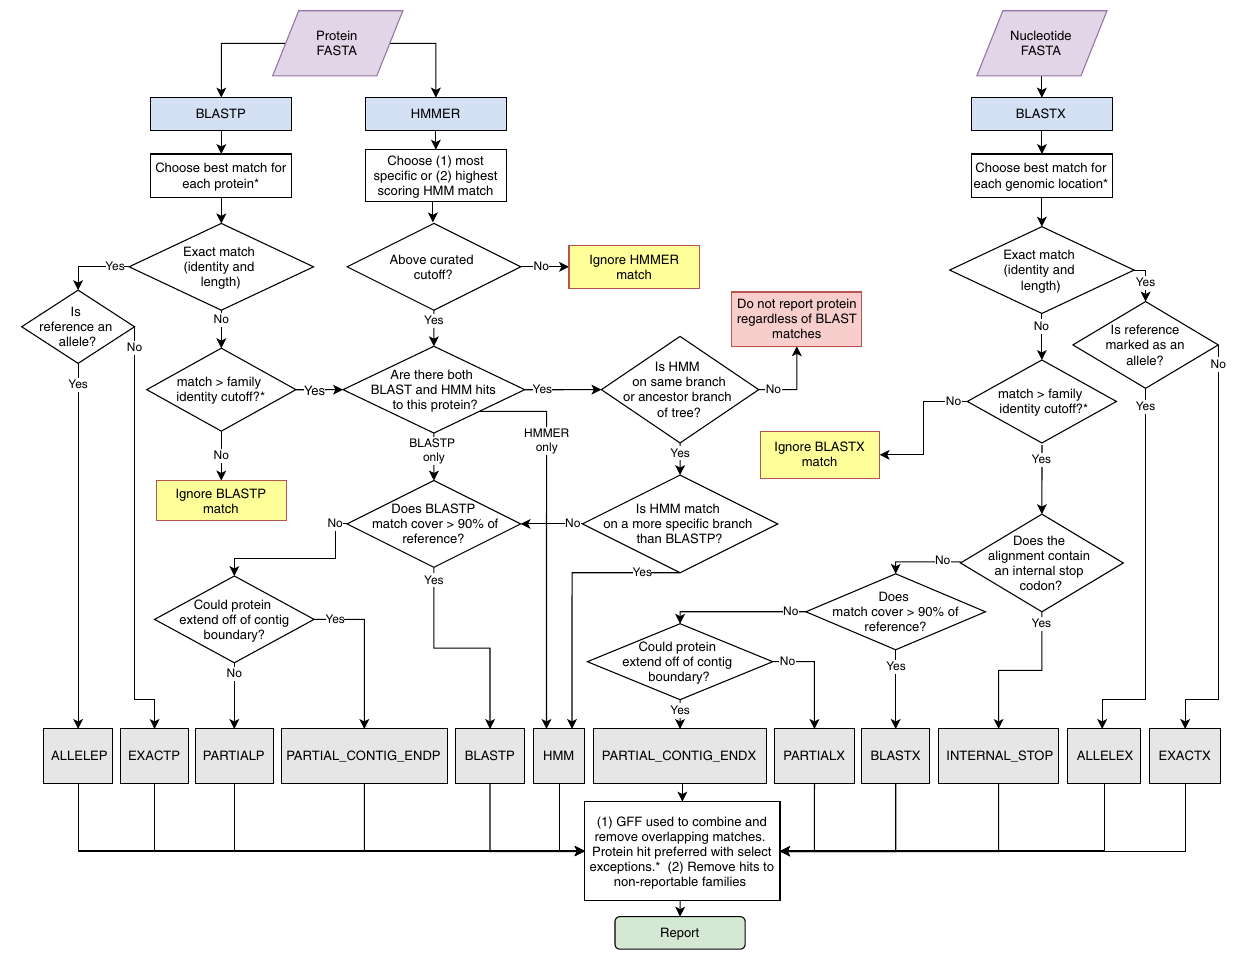
Figure 1. Overview of AMRFinderPlus gene identification method using protein and nucleotide sequences. When AMRFinderPlus is run in protein-only or nucleotide-only modes only the relevant side of the flowchart above is utilized. Note that HMMs are not used with nucleotide-only data which results in reduced sensitivity for some families. "Ignored" matches are not used, however an alternative method may still report the protein (e.g., an ignored HMM match will not suppress reporting based on BLASTP or BLASTX hit). *Details are simplified in this diagram; a more detailed description is included in the methods